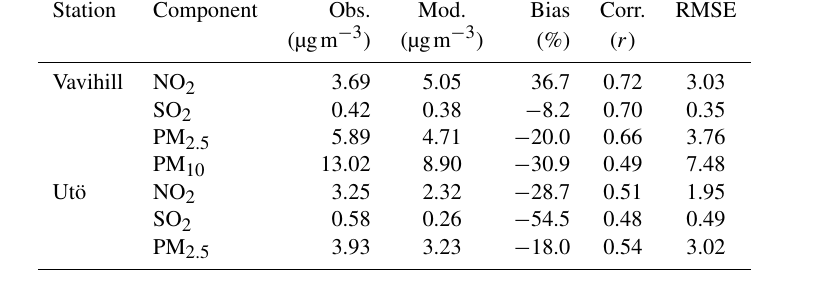
Table A1. Comparison of model daily concentration average results from the EMEP model and measured data for 2013 at Utö and Vavihill. Obs: observed data; Mod: modelled data; Corr: correlation coefficient; and RMSE: root mean square error.